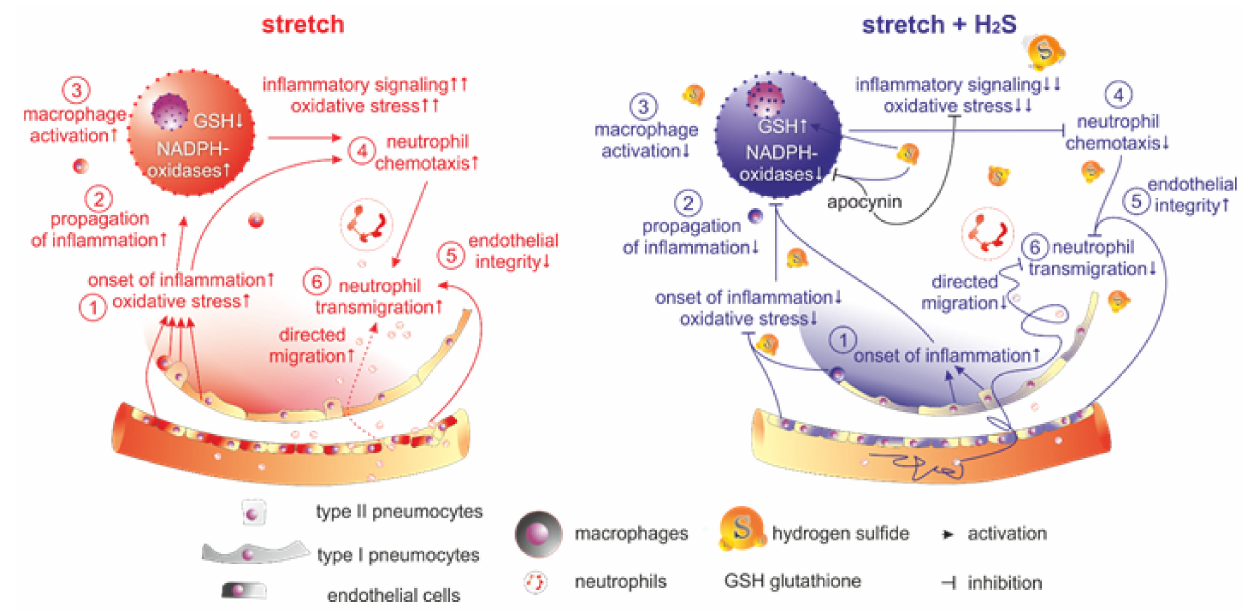
Figure 7. Summary of the effects of cyclic stretch and H 2 S on onset and propagation of inflammation. S. Serial numbers indicate onset and propagation of